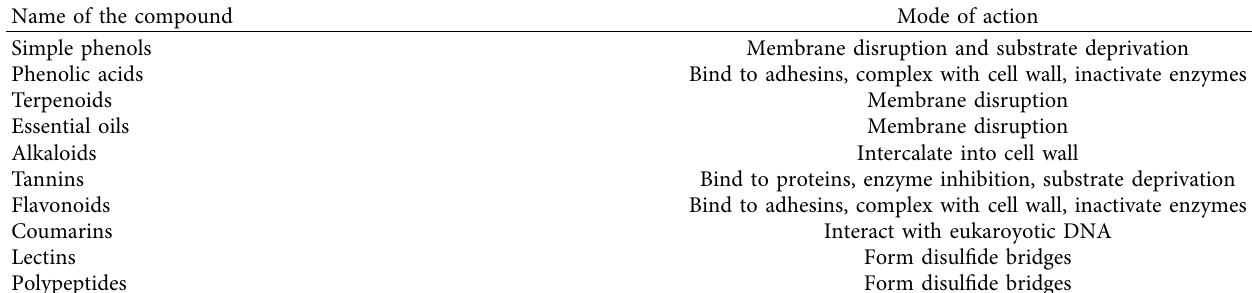
Table 4: Mechanisms of action of phytochemicals on fungal pathogens.